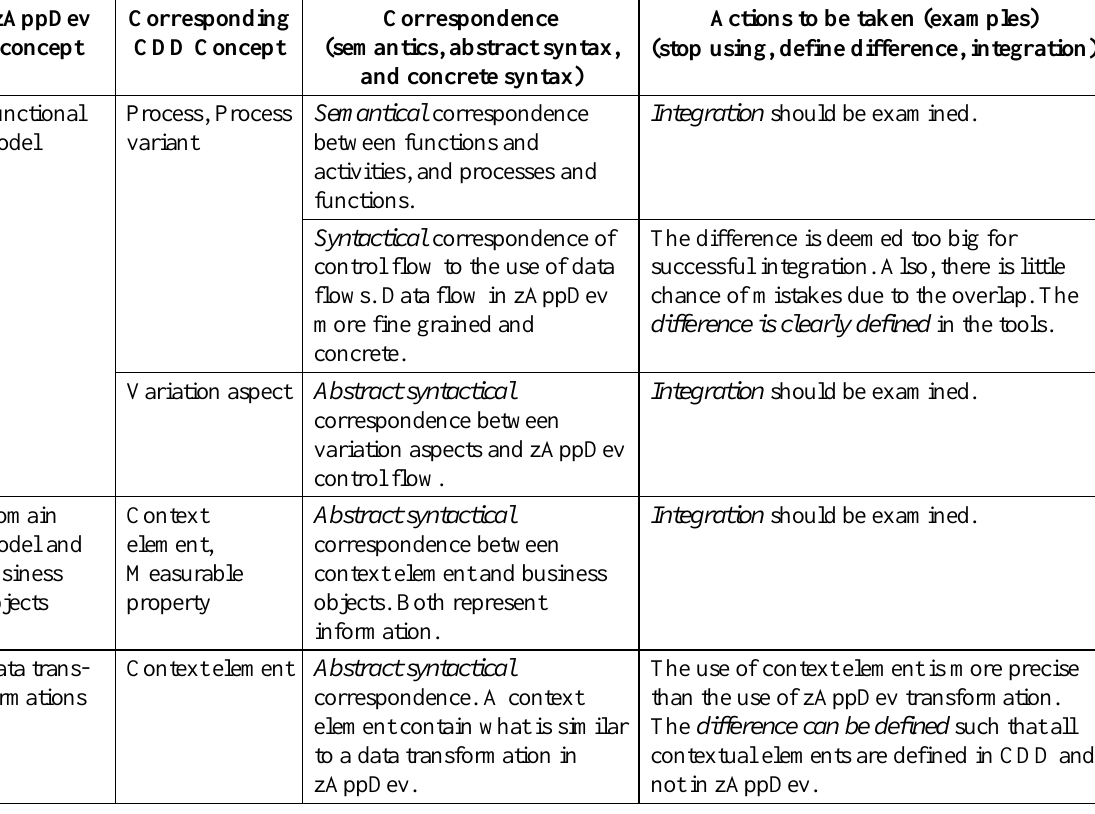
Table 2. Actions to be taken for overlapping